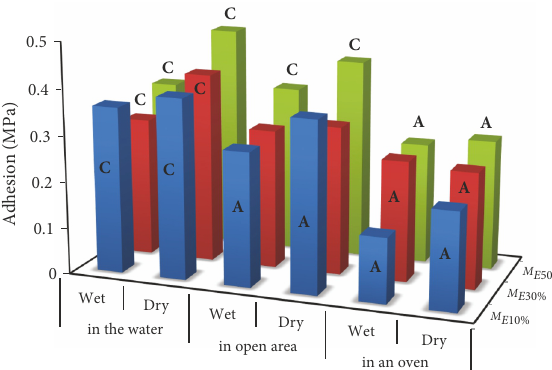
0.660Figure 4. Evolution of the bond stress during 28 d of storage in different environments with water saturation of the substrate: Mortar with earthenware ceramic